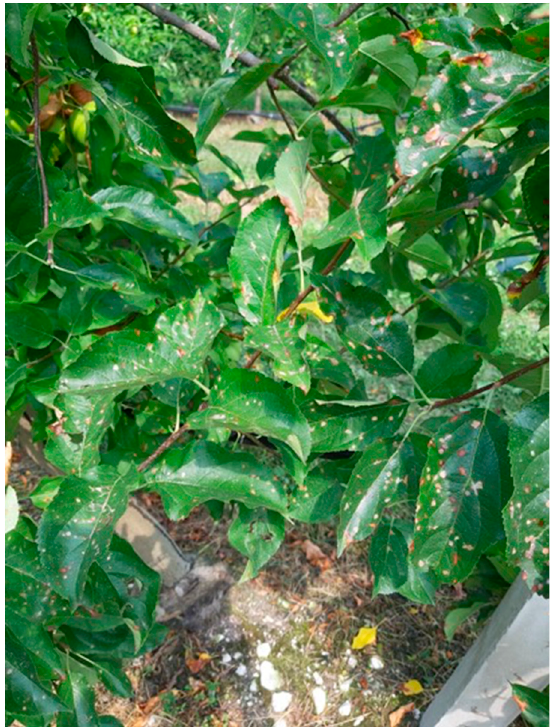
Figure 2. Codlemone phytotoxicity on leaves of the apple trees located in front of the aerosol device.